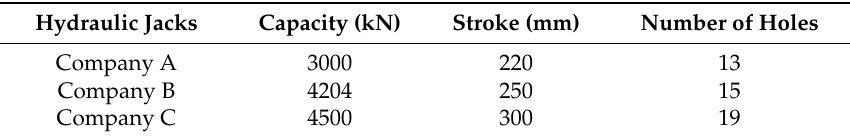
Figure 5. Prestressing and measurement on construction sites. Table 2. Hydraulic jacks used for the prestressing of girders and measurement of the prestress force